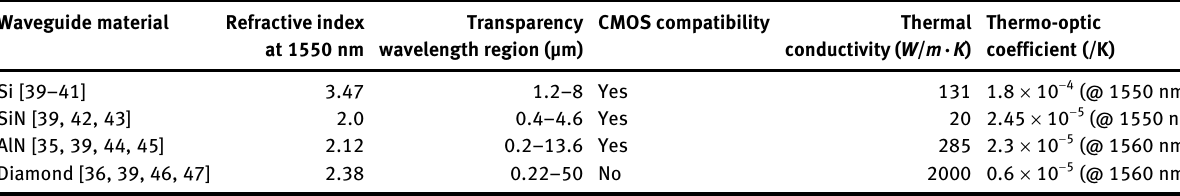
Table  : Comparison of optical and thermal properties of waveguide materials. Waveguide